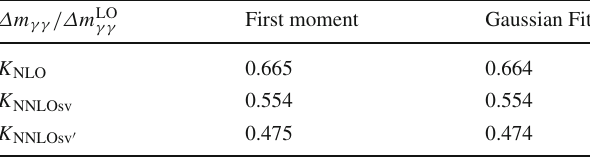
Table 3 Comparison of K -factors, measured w.r.t. the LO value, for √ s = 13 . 6 TeV calculated via a gaussian fit method the mass-shift at and via a first-moment method